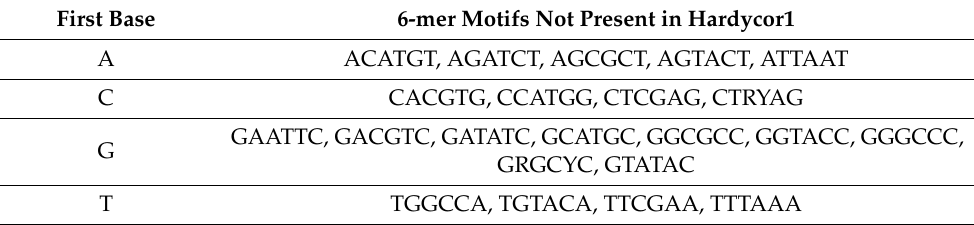
Table 3. Absent palindromic 6-mers in the Hardycor1 genome 1